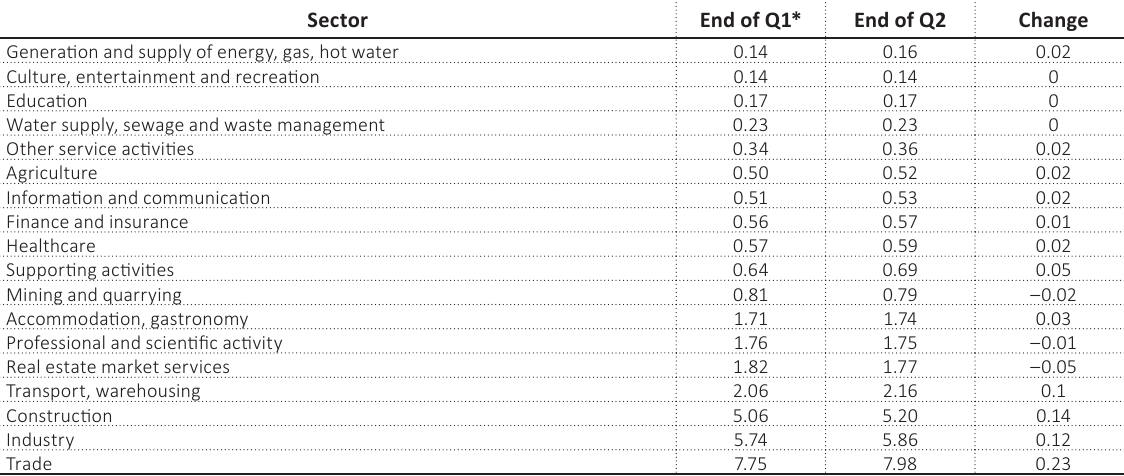
Table 1. Value of due payments at the end of the month (in PLN billion) Sector End of Q1* End of Q2 Change